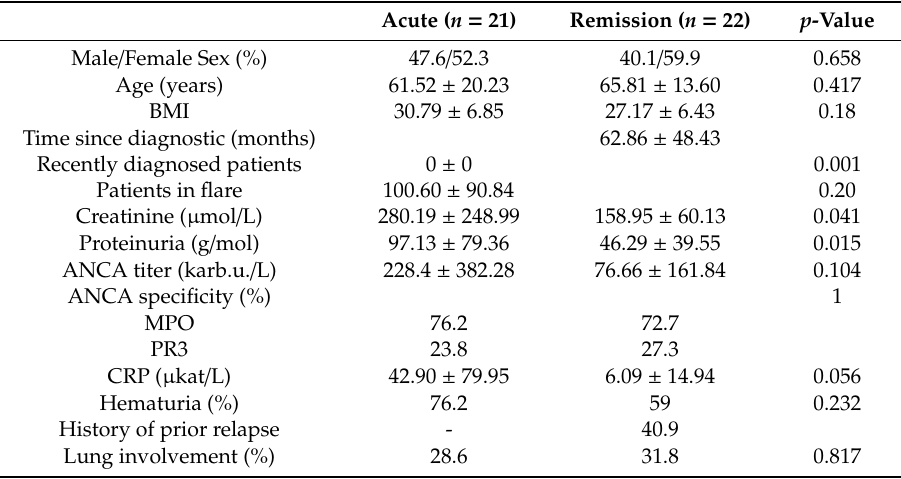
Table 1. Demographic characteristics of the AAV patients.